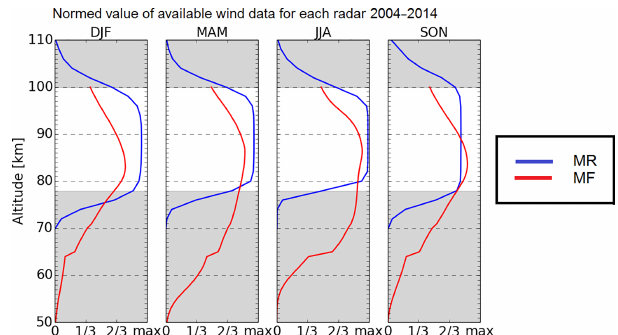
Figure 2. Altitude profile of the available wind data for the MR (blue) and the MF (red) according to season. The gray area shows the wind values for which at least one system is able to provide winds. The white area corresponds to the overlapping data area, which is used for